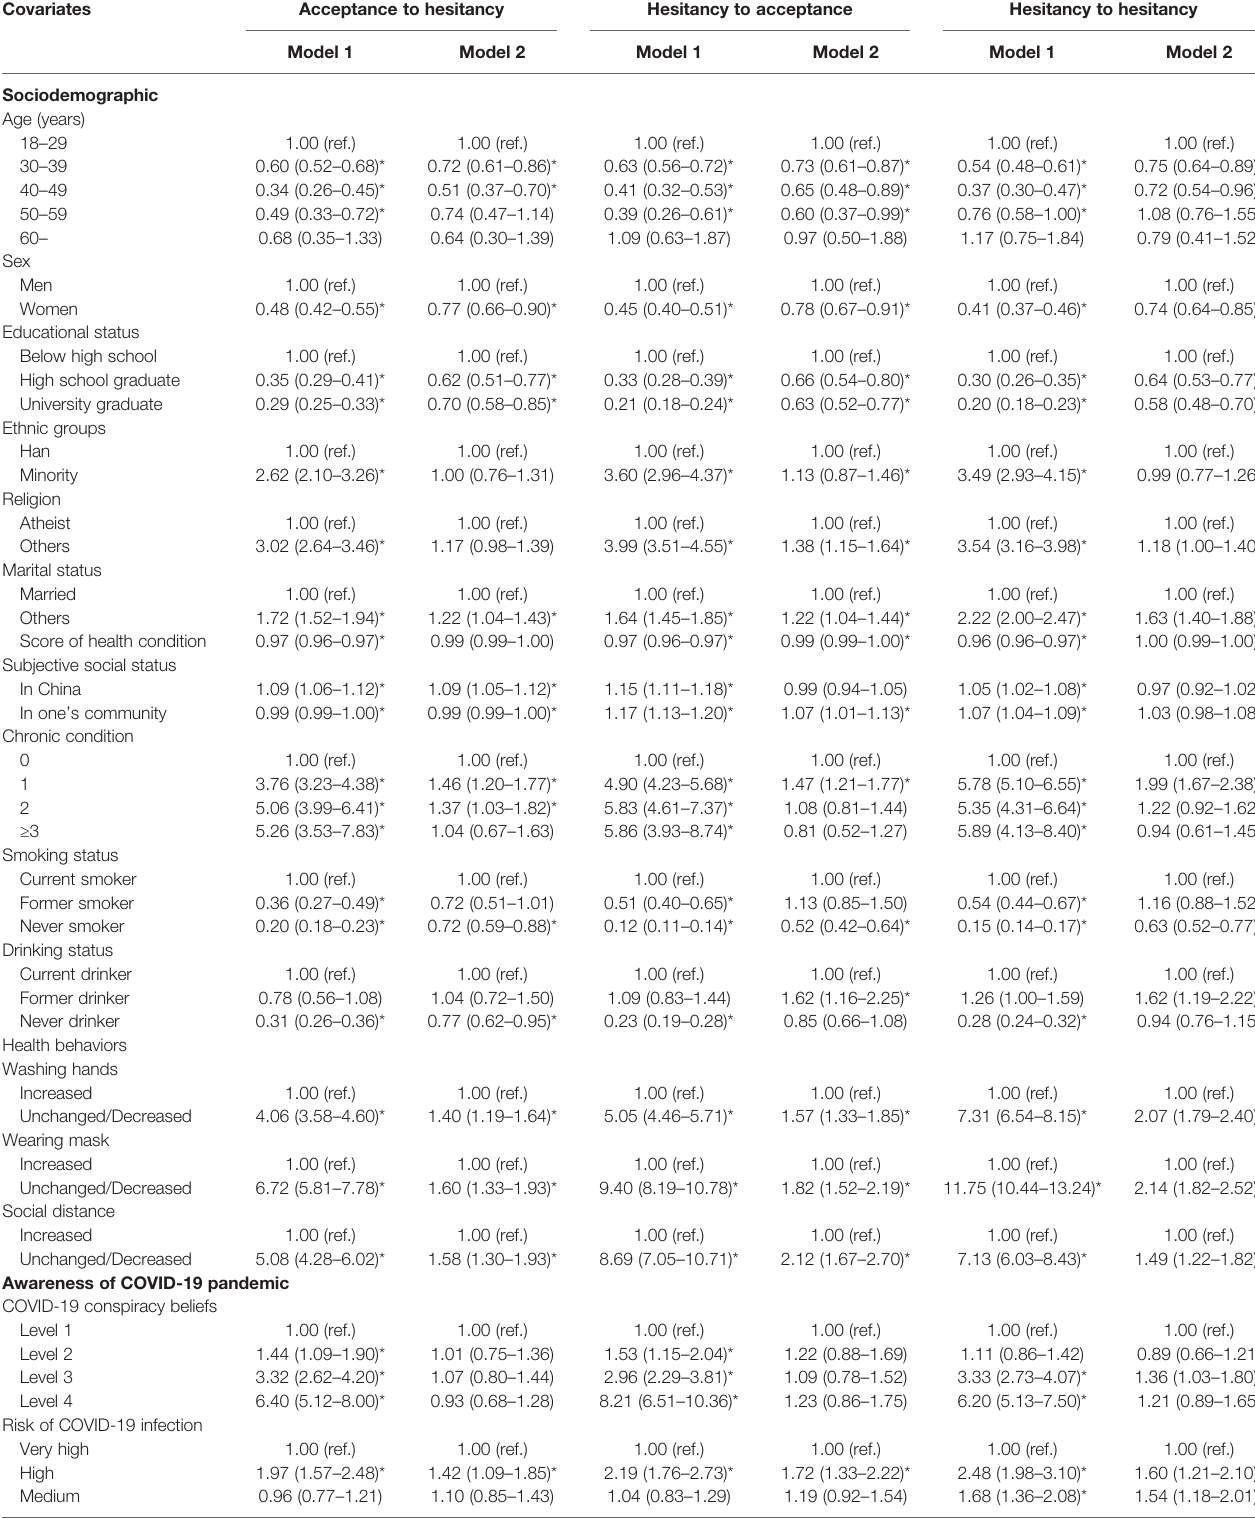
TABLE 3 | Associations between COVID-19 vaccine hesitancy transformations and sociodemographic, awareness of COVID-19 pandemic, COVID-19 vaccine exception, and trust in healthcare